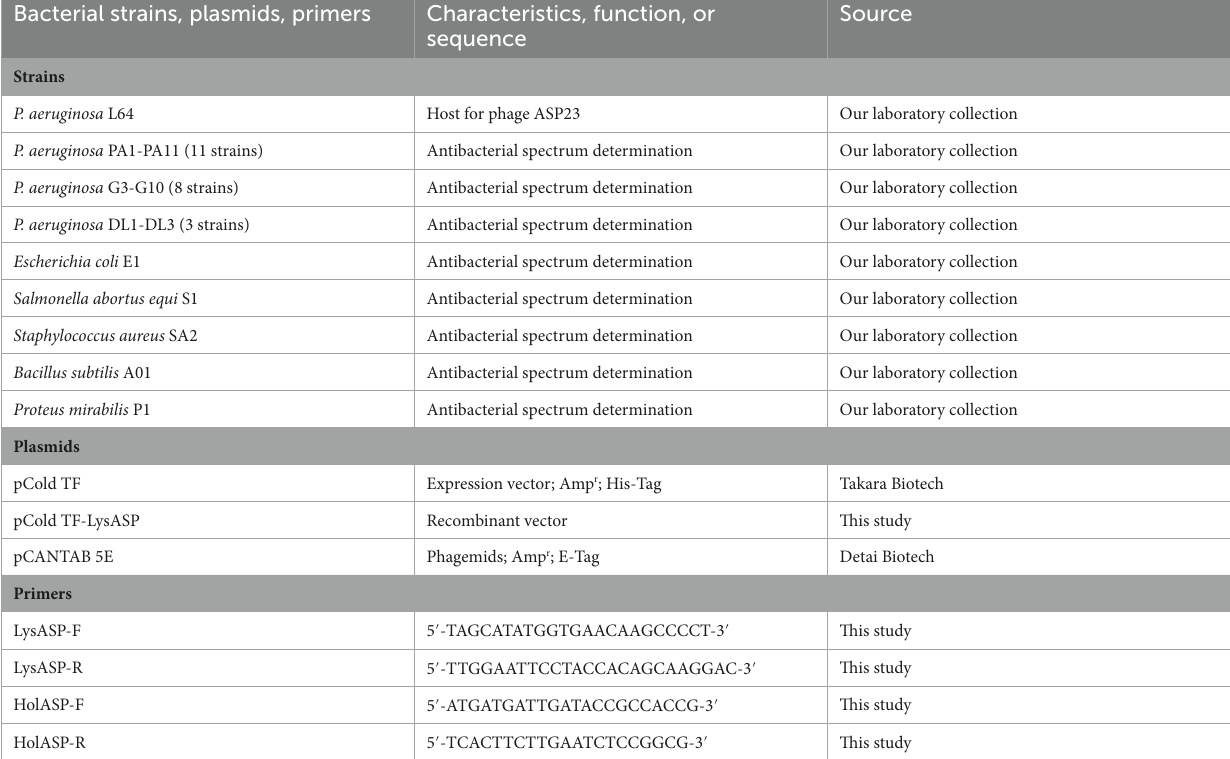
TABLE 1 Bacterial strains, plasmids, and primers used in this study. Bacterial strains, plasmids,